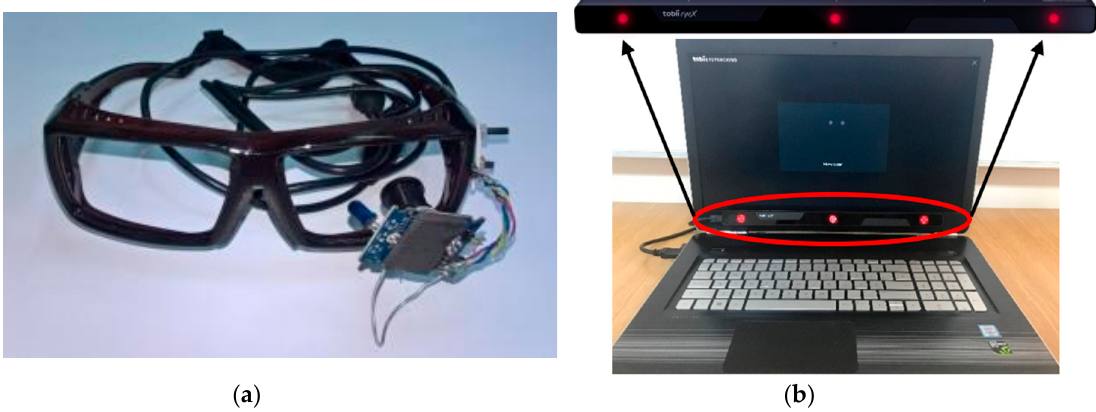
Figure 3. Eye-tracking-based interfaces: ( a ) head-mounted eye-tracking interface consisting of an infrared video camera mounted on an eyeglasses frame; ( b ) remote eye-tracking interface consisting of a commercially available infrared sensor mounted on the patient’s laptop.